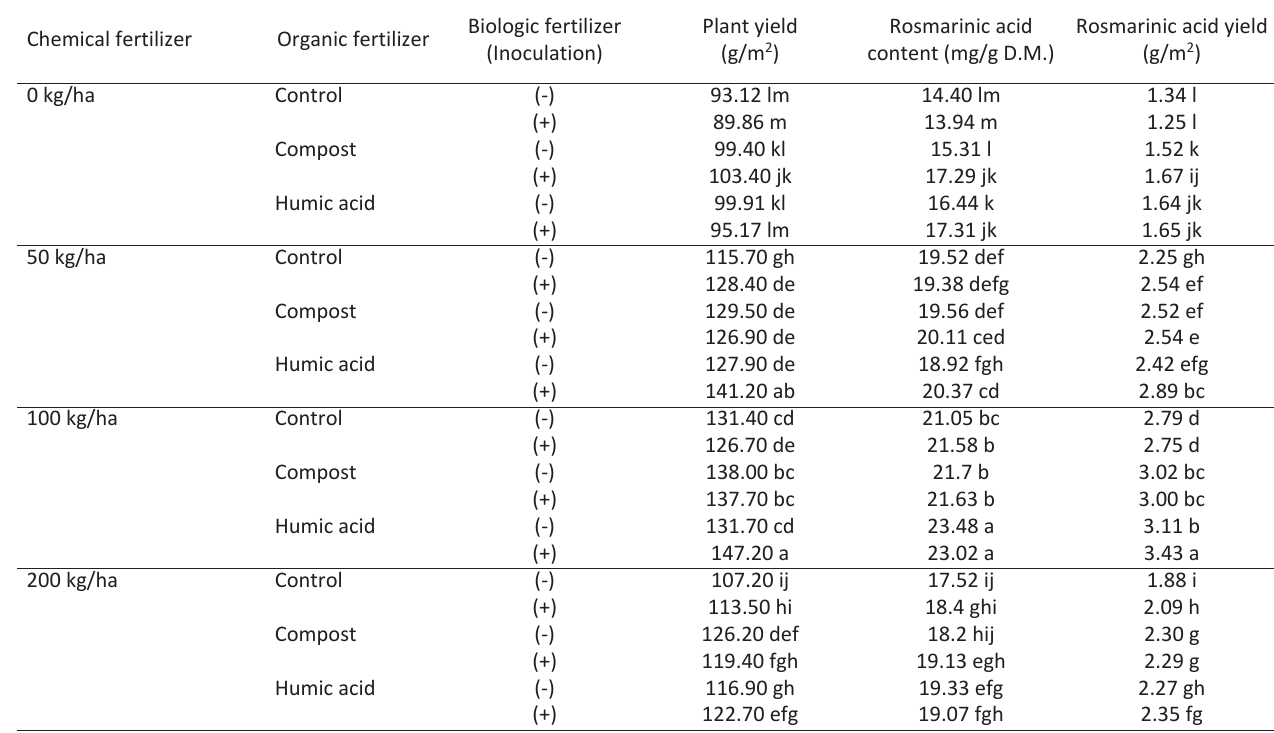
Table 6 - Means comparison of some morphologic, yield and essence traits of Perilla under different fertilizer systems in Sensen and Mashhad Ardehal in Kashan regions Chemical fertilizer Organic fertilizer